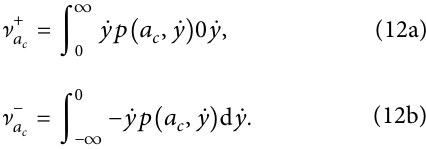
k � − 1). (a) The analytical results. 1